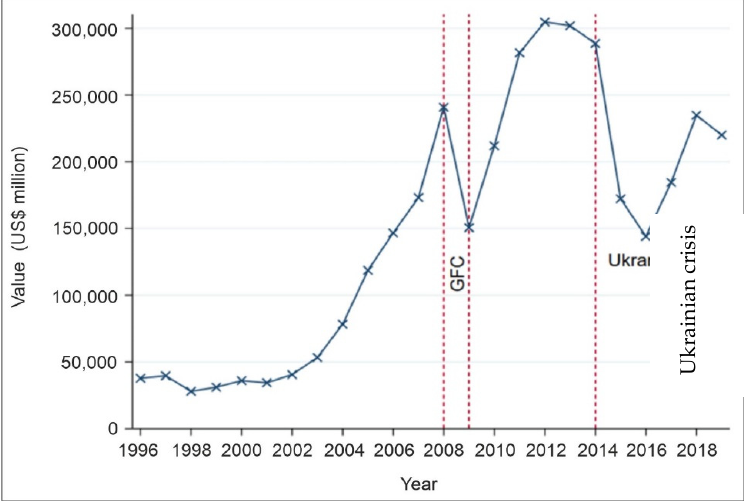
Figure 4. Russian non-renewable energy export values (1996–2019). Note: GFC is Global Financial Crisis that happened in 2008/9, while abbreviation Ukran is the country Ukraine with the event in the highlighted period Ukrainian crisis been the annexation of Crimea. Source: Authors’ elaboration based on data retrieved from CEPII database.